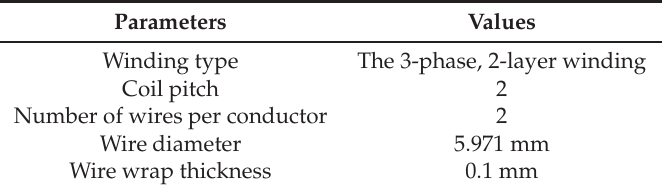
Table 5. Winding